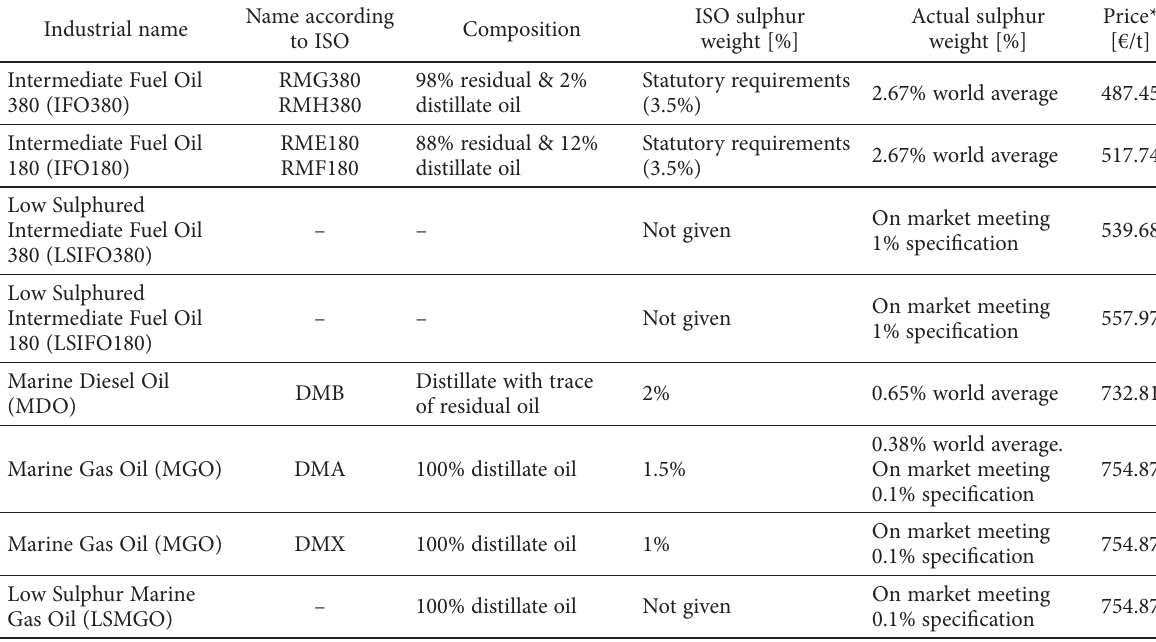
Table 5. Specifications of marine